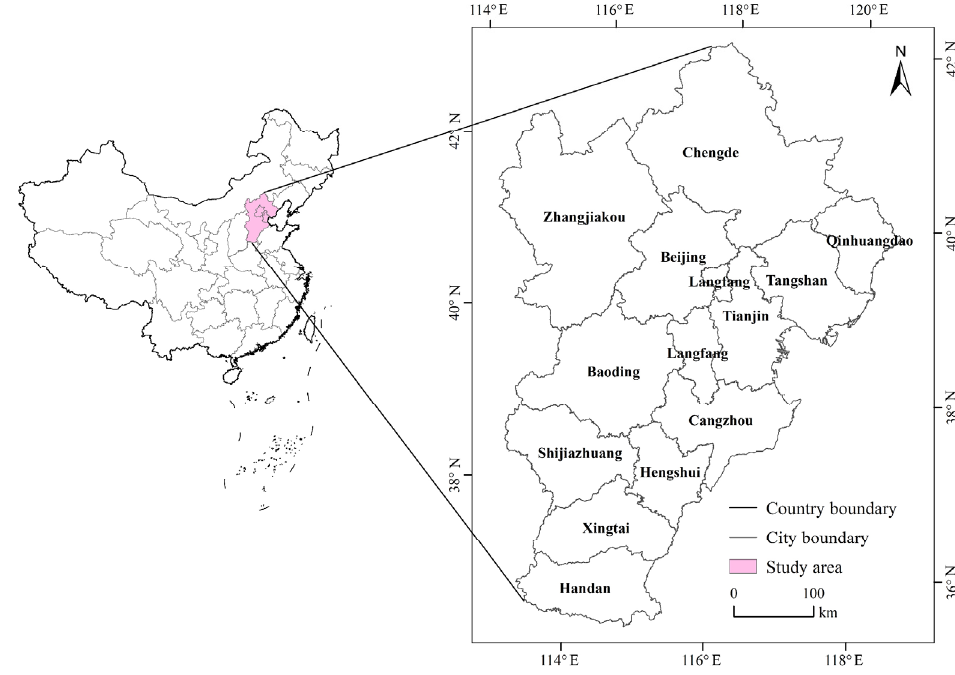
Figure 1. The location of the Beijing–Tianjin–Hebei urban agglomeration in China.